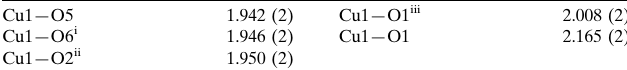
Selected bond lengths (A˚ ).